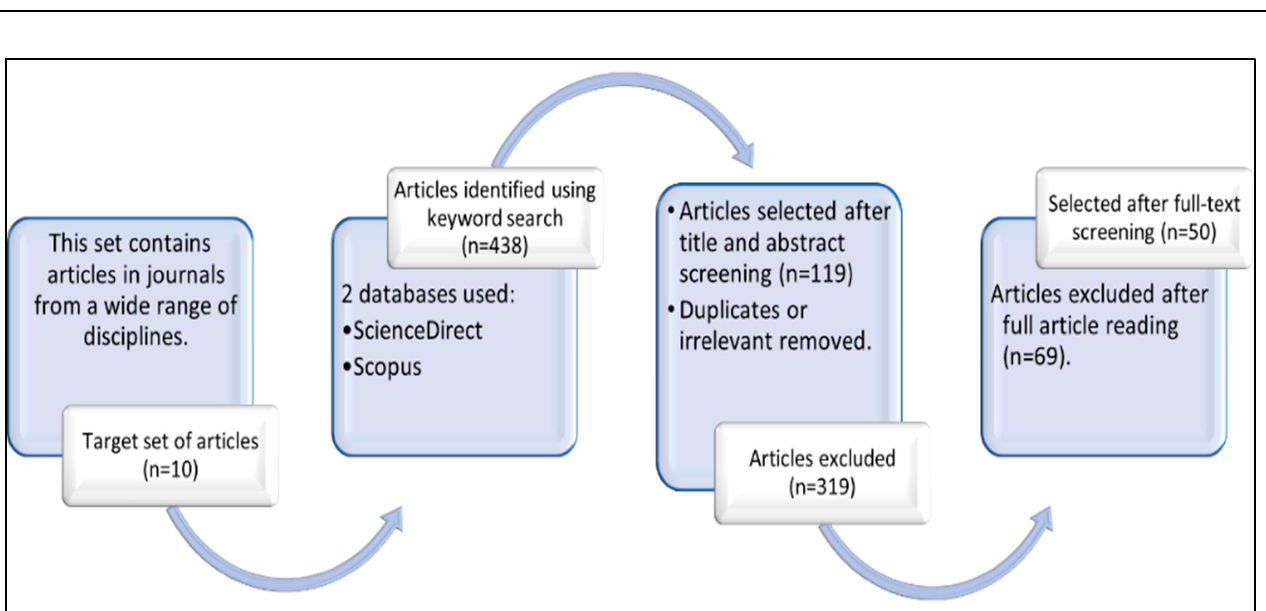
Figure 1. Steps involved to assemble research articles for this analysis. Table 1. Description and sources of all the datasets used in this analysis.